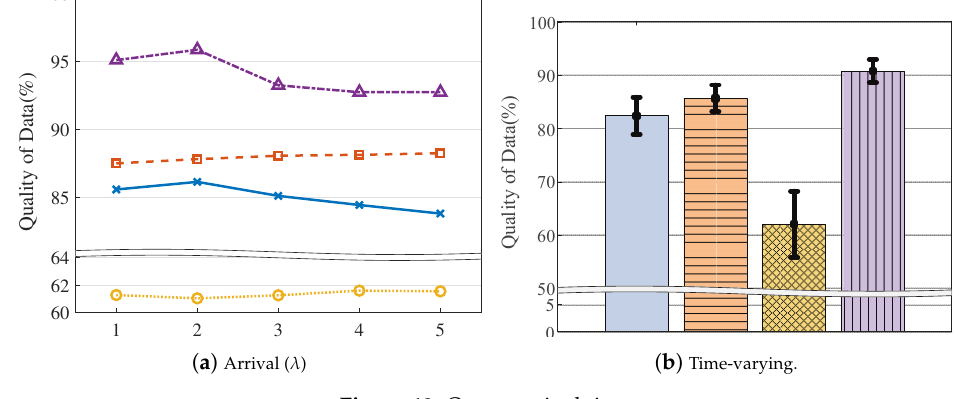
Figure 12. Query arrival time.